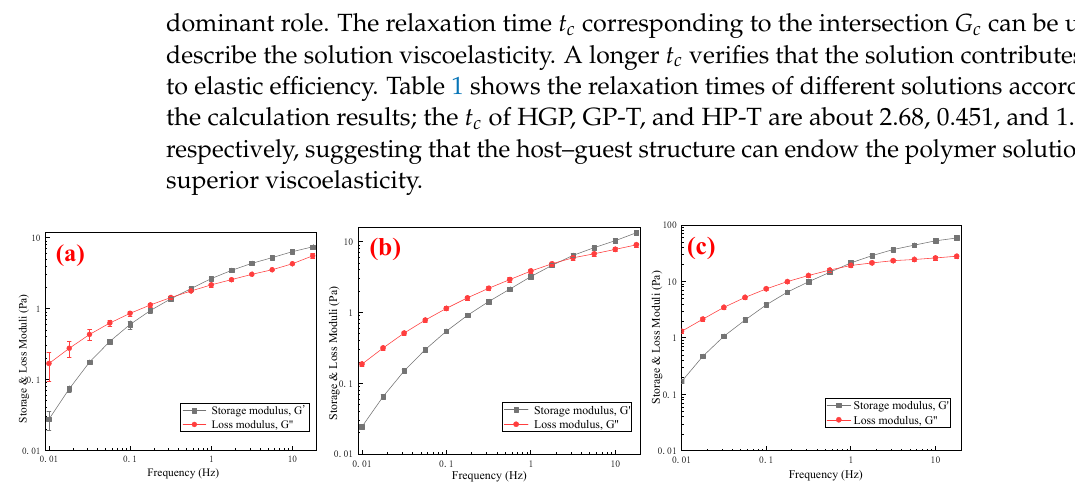
Table 1. Crossover frequencies and longest relaxation times of three polymer solutions.